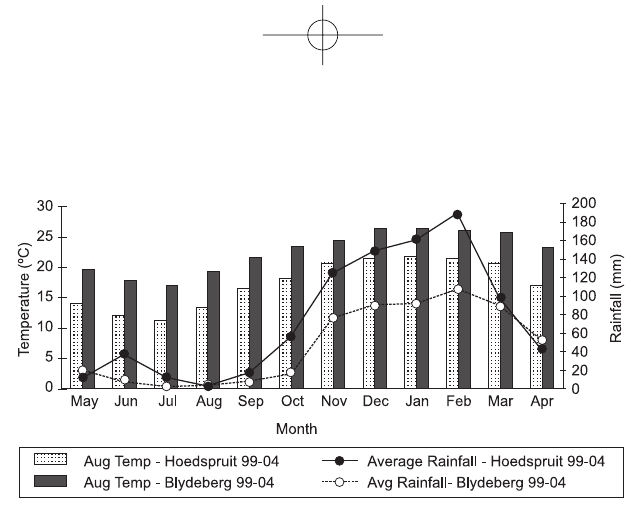
Fig. 2. Average monthly rainfall and temperatures for the Blydeberg Con- servancy and Hoedspruit from 05/1999 to